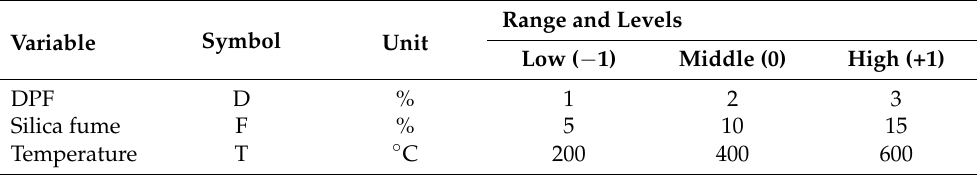
Table 5. Variables’ range and